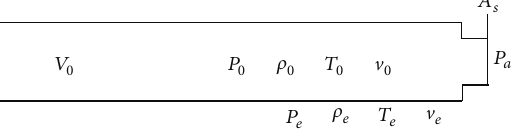
Figure 1: Equivalent structure of